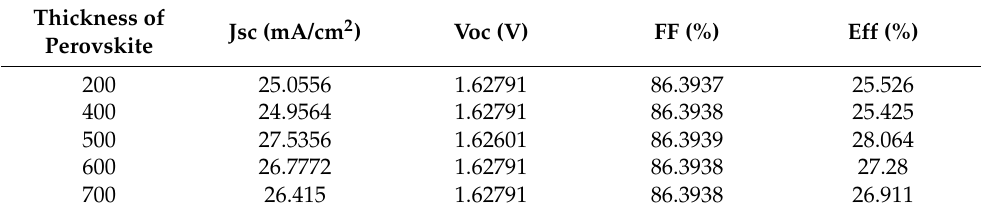
Figure 4. Effect of perovskite layer thickness variation on the efficiency of the inverted planar PSC. Table 2. Effect of perovskite layer thickness variation (CH3NH3PbI3) on the efficiency of the inverted planar perovskite solar cell.